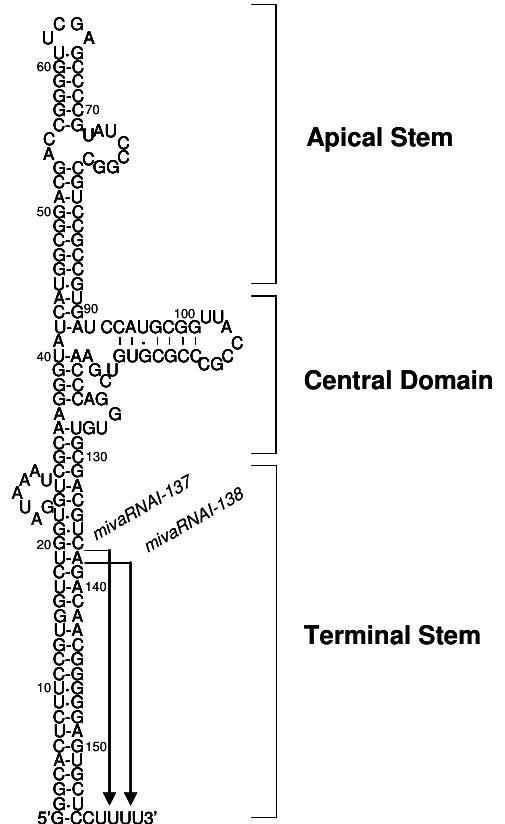
Figure 1. Secondary structure of VA-RNA-I. VA-RNA is composed of the apical stem, the central domain, and the terminal stem. VA-RNA-I is processed into two major species of mivaRNAs (mivaRNAI-137 and